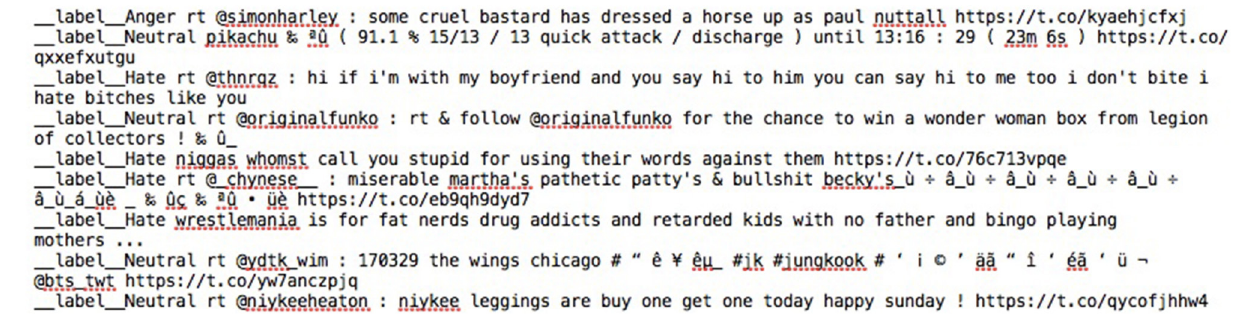
Frontiers in Robotics and AI |